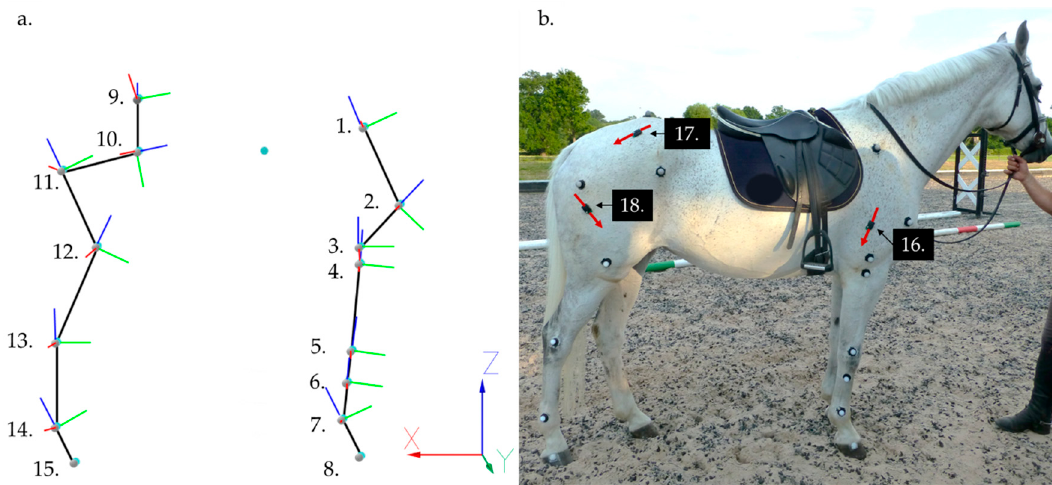
Figure 1. ( a ) The rigid segment model created for the subject in ( b ), showing marker locations (white spheres) and virtual landmarks (turquoise spheres), including the virtual CM maker. Black lines indicate segments. Red, green and blue lines indicate the mediolateral, anterior–posterior and dorsoventral axes, respectively, of each segment coordinate systems (SCS). Anatomical locations for marker placement are as follows: 1. proximal end of the spine of the scapula, 2. greater tubercle of the humerus (representing center of rotation of the shoulder joint), 3. lateral epicondyle of the humerus (center of rotation of the elbow joint), 4. lateral tuberosity of the radius, 5. lateral styloid process of the radius, 6. proximal end of metacarpal IV, 7. the metacarpal epicondyle (center of rotation of the metacarpophalangeal joint (MCPJ)), 8. lateral hoof wall (approximately over center of rotation of the distal interphalangeal joint (DIPJ)), 9. between the tubera sacrale, 10. most ventral part of the tuber coxae, 11. greater trochanter (center of rotation of the hip joint), 12. lateral epicondyle of the femur (center of rotation of the stifle joint), 13. talus (center of rotation of the tarsal joint), 14. the metatarsal epicondyle (center of rotation of the metatarsophalangeal joint (MTPJ)), and 15. the lateral hoof wall. ( b ) Anatomical locations for sEMG sensor placement are as follows: 16. triceps brachii, 17. middle gluteal, and 18. biceps femoris. Red arrows indicate the orientation of sEMG sensors, which ensured that electrode bars were orientated perpendicular to underlying muscle fiber direction.